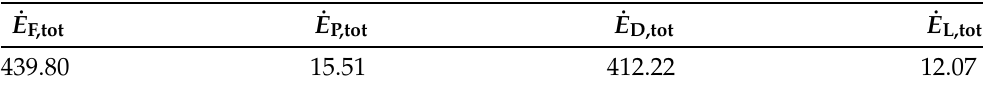
Table 9. Air refrigeration cycle—Results of the exergy analysis, overall process. All values given in kW.